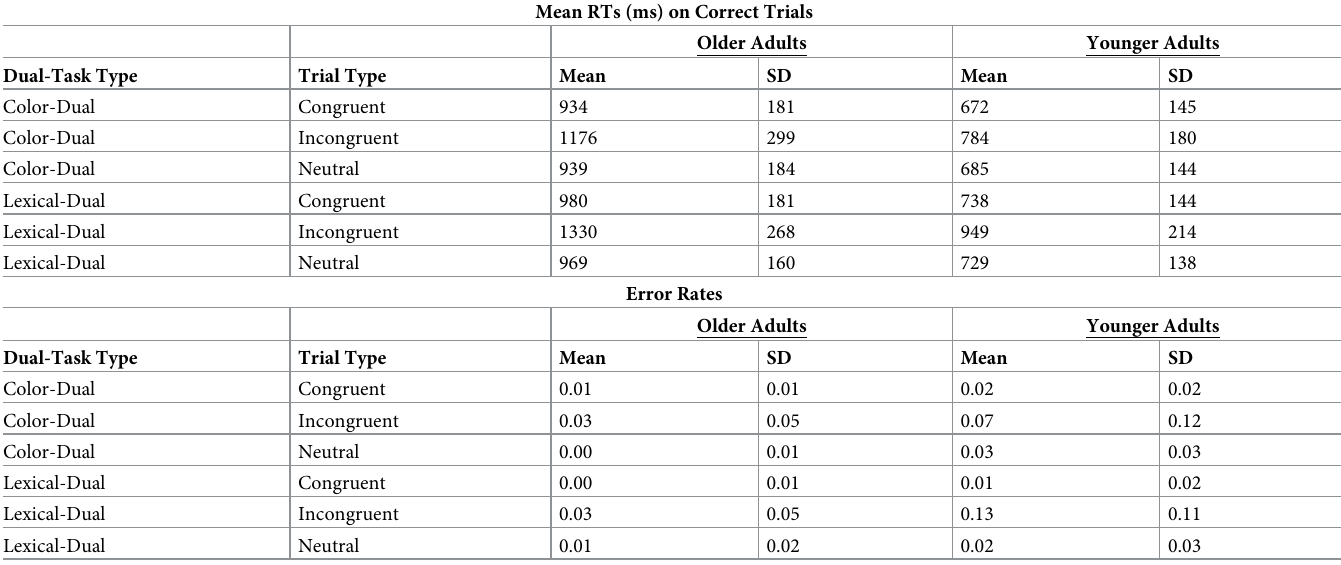
Table 3. Dual-task descriptive statistics for primary task response latency and accuracy.